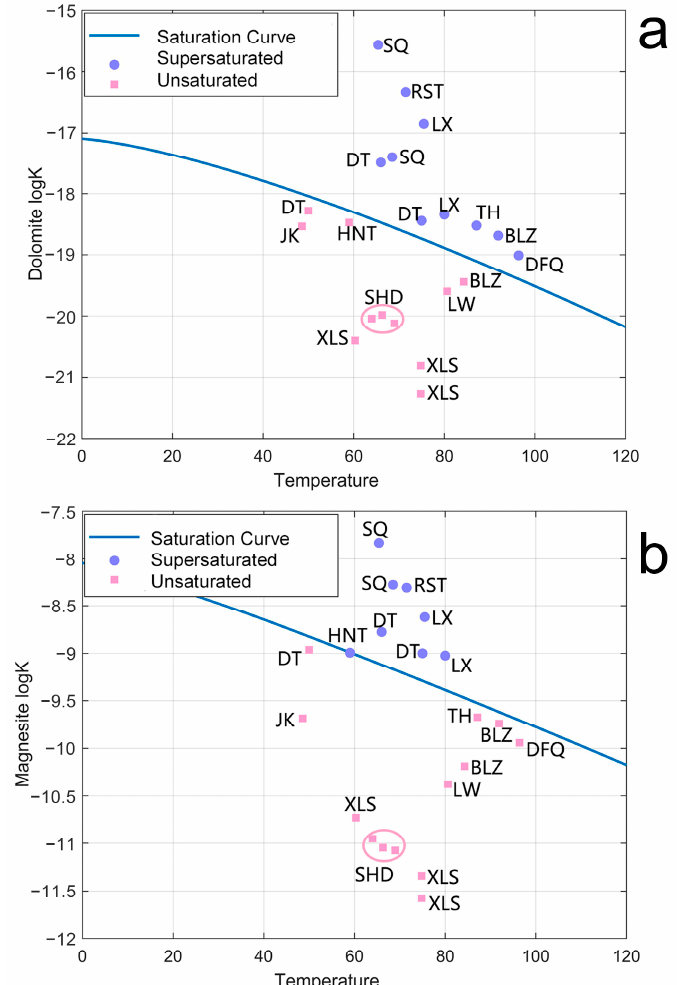
Figure 7. The solubilities of ( a ) dolomite and ( b ) magnesite of the Tengchong hydrothermal fluids. The blue curves demonstrate precipitation and dissolution equilibria.